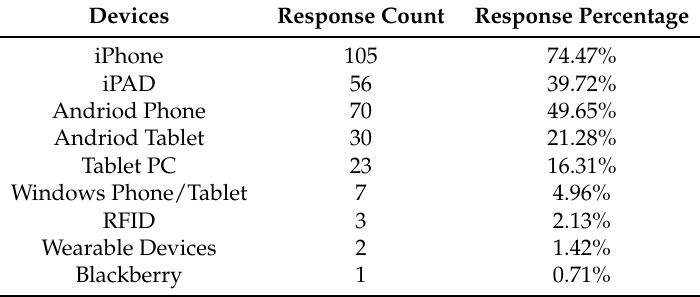
Table 2. Mobile Devices Used in New Zealand Construction Industry.